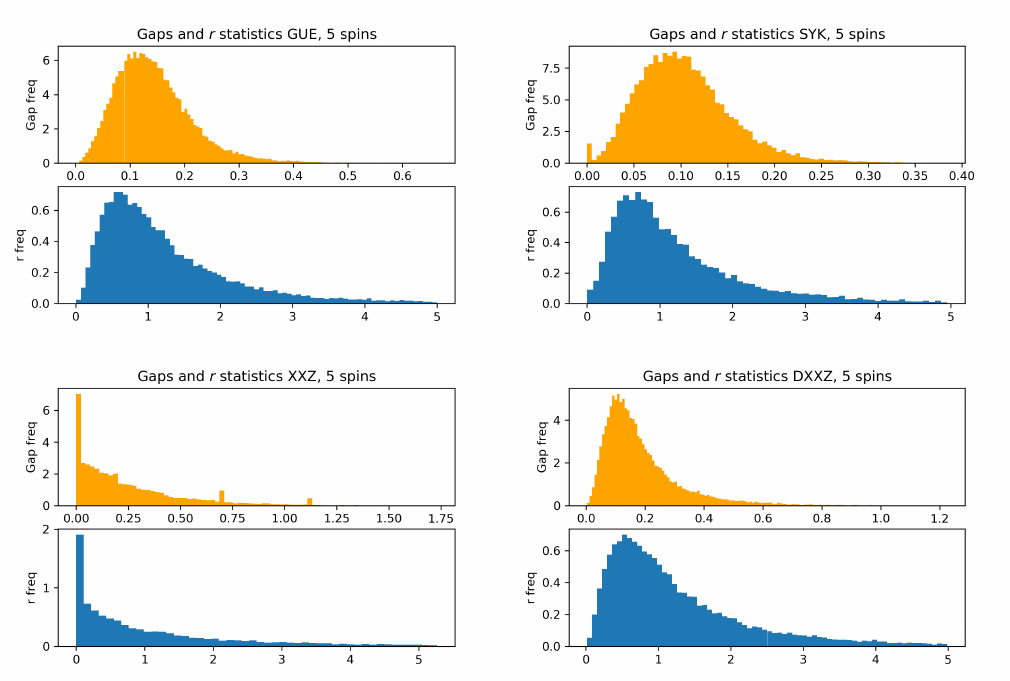
Figure 17: Distribution of energy gaps in various ensembles, along with subsequent gap ratio. Of the four pictured, the XXZ has the Poissonian character of an integrable model, the other three appear more Wigner-Dyson. XXZ is taken here with J = B =